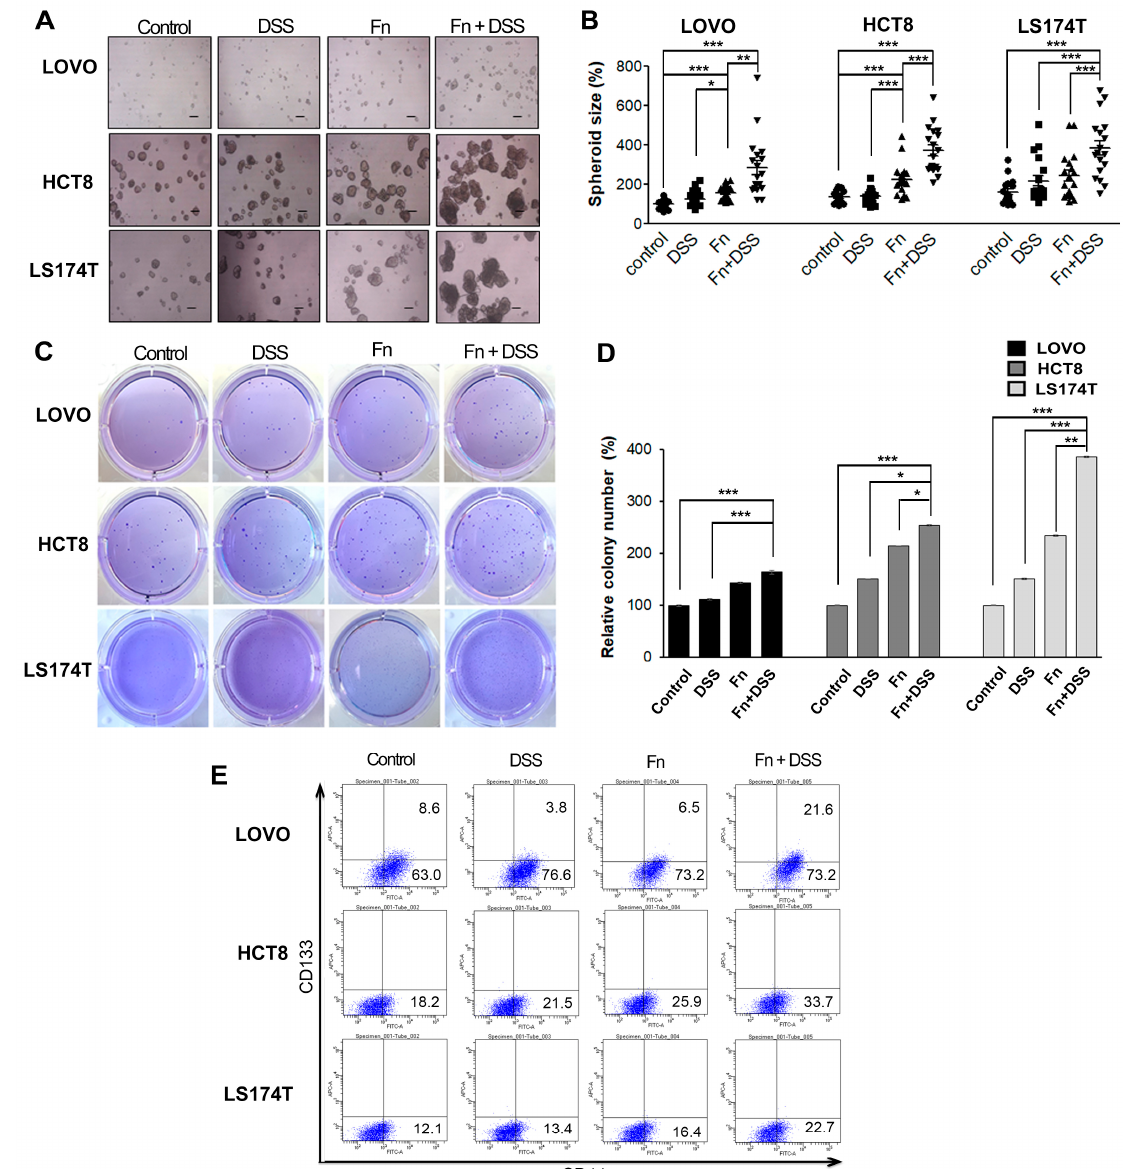
Figure 4. F. nucleatum enhances the stemness of colorectal cancer cells. ( A ) Effects of F. nucleatum on the sphere formation ability of CRC cells. CRC cells (LOVO, HCT8, and LS174T) were subjected to a sphere formation assay for 3 d after treatment with vehicle, DSS, F. nucleatum , or F. nucleatum + DSS. Representative images of spheres of CRC cells are shown. Scale bar, 200 µ m. ( B ) Graphs presenting the mean diameters of spheres. ( C ) Colony-formation ability of CRC cells in a soft agar assay. ( D ) Graph presenting the mean diameters of spheres. ( E ) Expression profiles of CD133 and CD44 in CRC cell lines characterized using flow cytometry. Cell suspensions were labeled with PE-conjugated anti-CD133 and FITC-conjugated anti-CD44 antibodies and analyzed using a flow cytometer. Isotypic controls were used to establish the right gating. The number of double-positive cells in the right top quarter is expressed as a percentage of total cells. The graph represents relative levels from three independent experiments. The data are presented as the mean ± SEM (* p < 0.05, ** p < 0.01, and *** p < 0.001; unpaired Student’s t -test). Abbreviations: DSS, dextran sodium sulfate; Fn, F. nucleatum